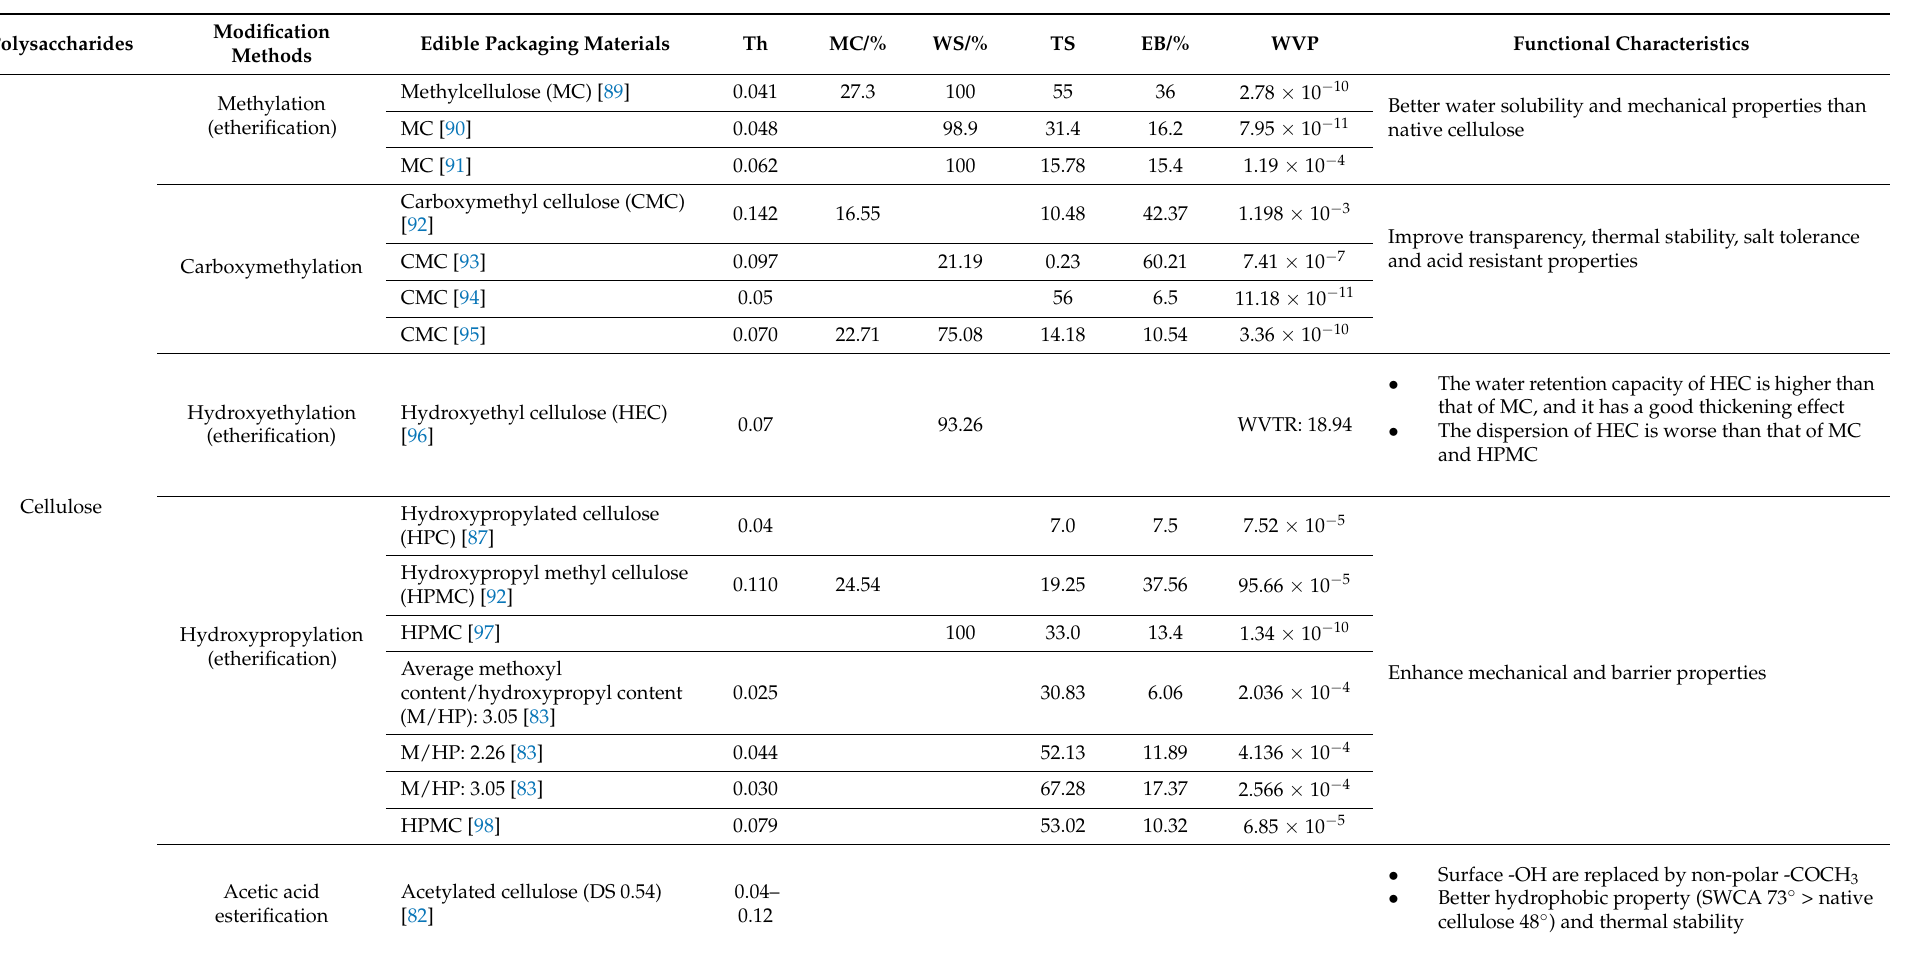
Table 2. Chemical modification methods and effects of various